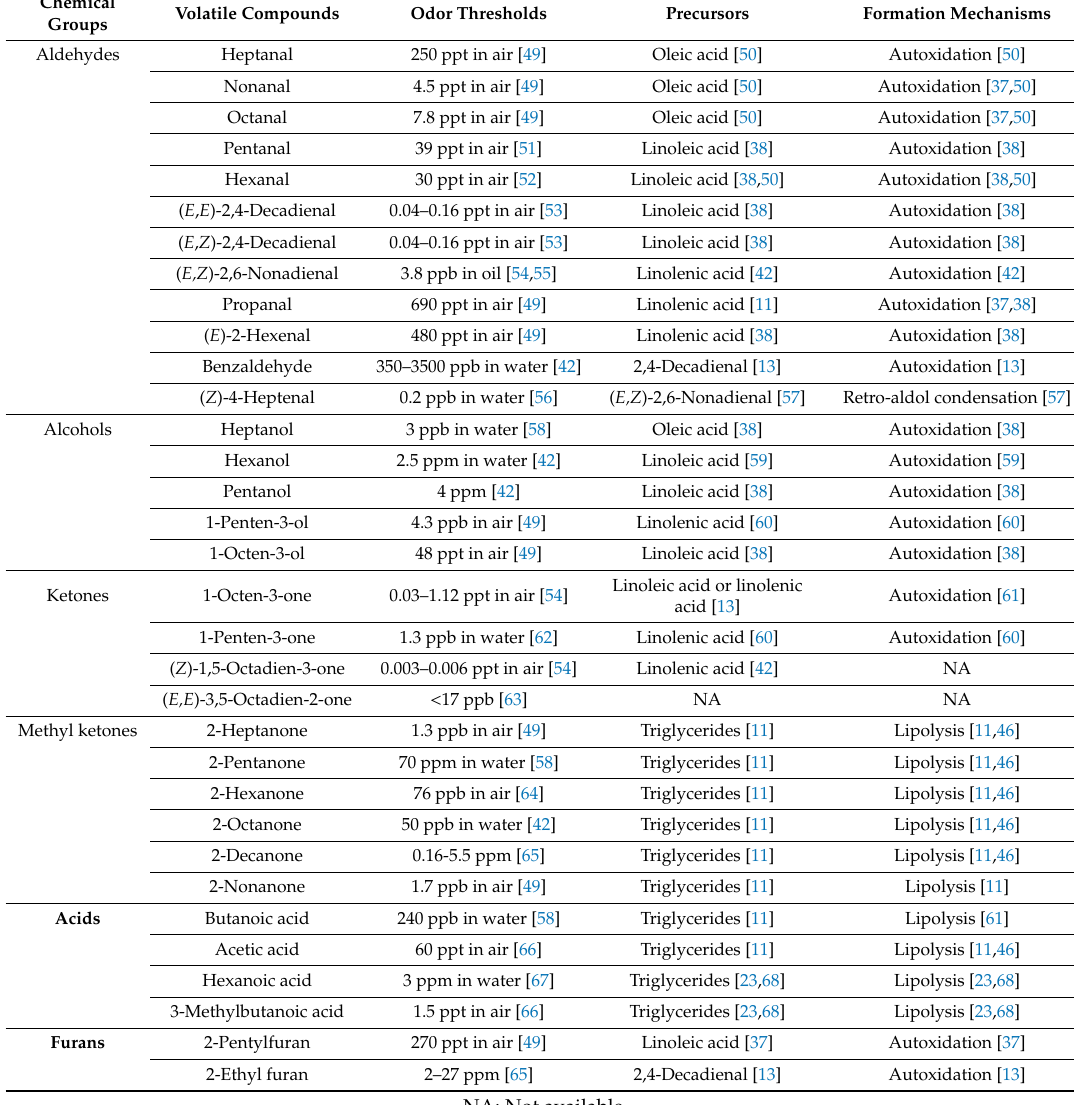
Table 2. Odor thresholds and formation mechanisms of o ff -aroma compounds derived from lipid autoxidation and lipolysis.